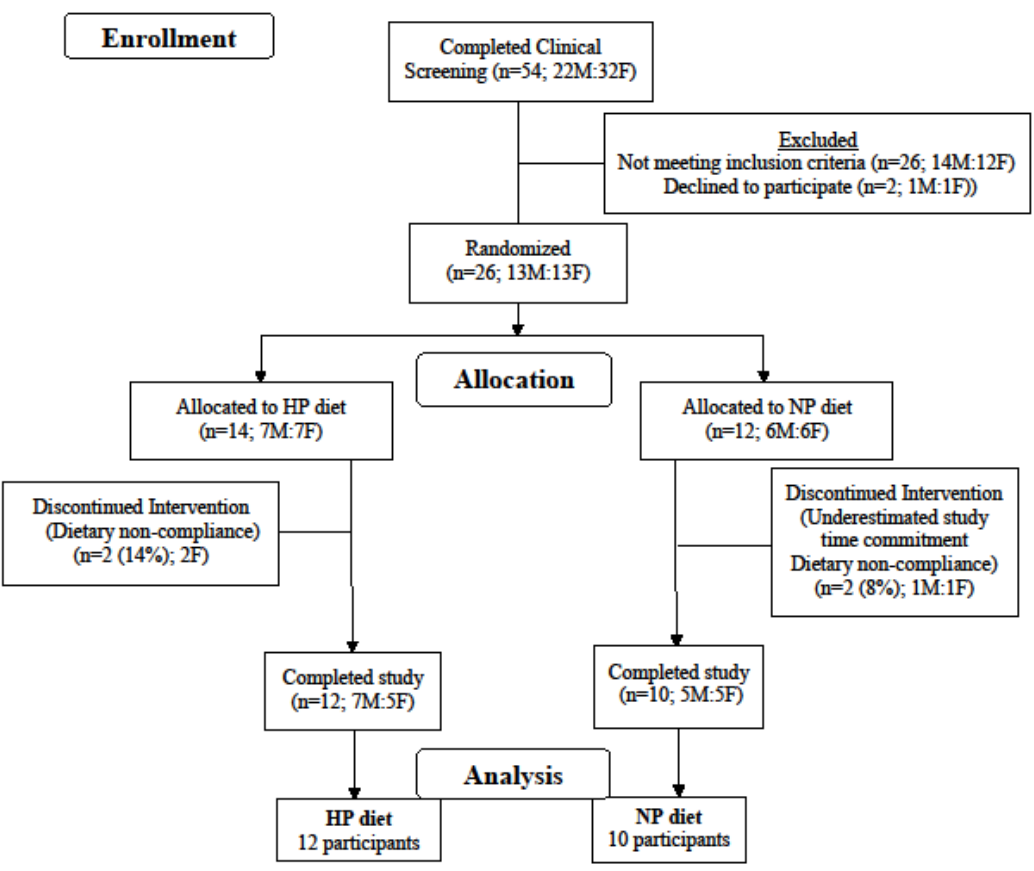
Figure 1. Consolidated Standards of Reporting Trials flow diagram. Flow of participants and study analysis. Females, F; High protein, HP; Males, M; Normal protein, NP.